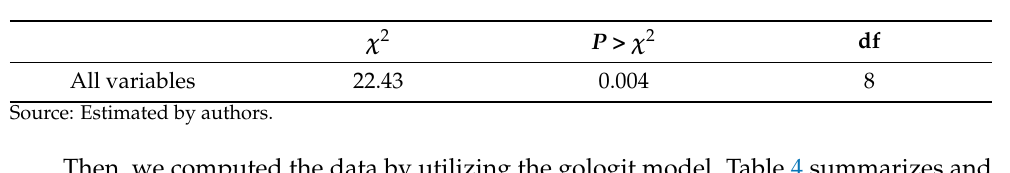
Table 3. Brant test.